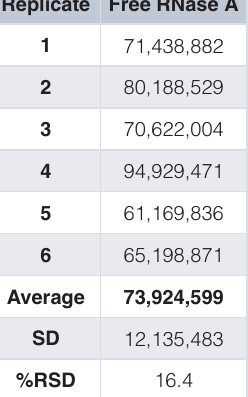
approximately 20% or less (Table 5). A plot of the total ion abundance for free RNase A, RNase A+dC , and RNase 5 A+dC AC as a function of [deoxyoligonucleotide] is shown in 2 2 Figure 2. The total ion abundance for RNase A+dC and RNase 5 A+dC AC increased until 20 μM deoxyoligonucleotide, but 2 2 decreased at 40 μM (Figure 2). Table 6 presents the calculated total ion abundance ratio ( R ) and dissociation constant ( K ) d at each [deoxyoligonucleotide]. Samples containing <40 μM deoxyoligonucleotide unexpectedly produced negative K d values (Table 6). By contrast, Table 6 shows that samples containing 40 μM deoxyoligonucleotide produced consistent positive values where the average K for dC was 2.2 ± 0.1 μM d 5 and the average K for dC AC was 1.0 ± 0.1 d 2 2